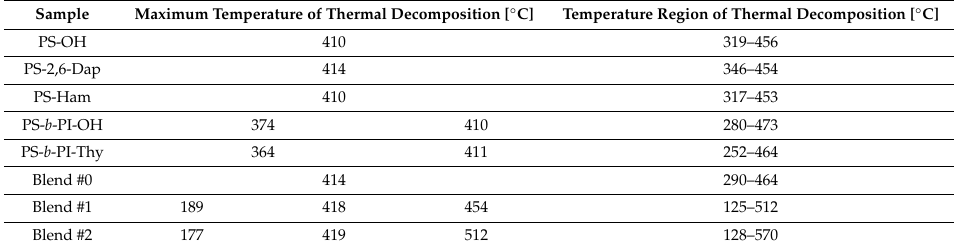
Table 5. TGA results of the end-functionalized polymers and the blends.